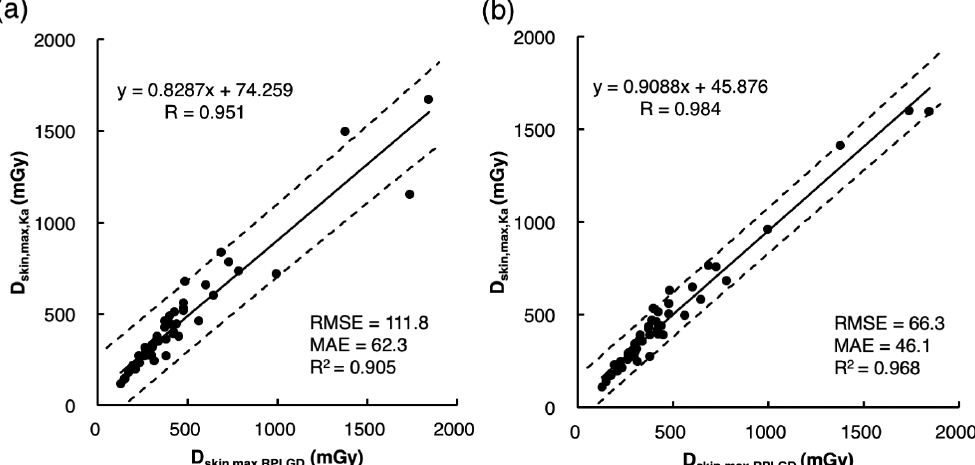
Figure 5. Investigation of the accuracy of the two indirect methods of estimating D skin,max,Ka using the validation data set ( n = 50). ( a ) Correlation between the value of D skin,max,Ka estimated indirectly using an arbitrary constant CF Ka,constant (Estimation Model 1) and D skin,max,RPLGD directly estimated using RPLGDs; ( b ) correlation between the value of D skin,max,Ka estimated indirectly using an arbitrary quadratic function CF Ka,function (Estimation Model 2) and D skin,max,RPLGD directly estimated using radio-photoluminescence glass dosimeters (RPLGDs). The broken lines indicate 95% predictive intervals.